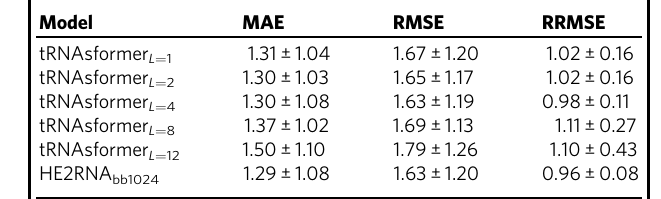
Table 2 Prediction error for tRNAsformer